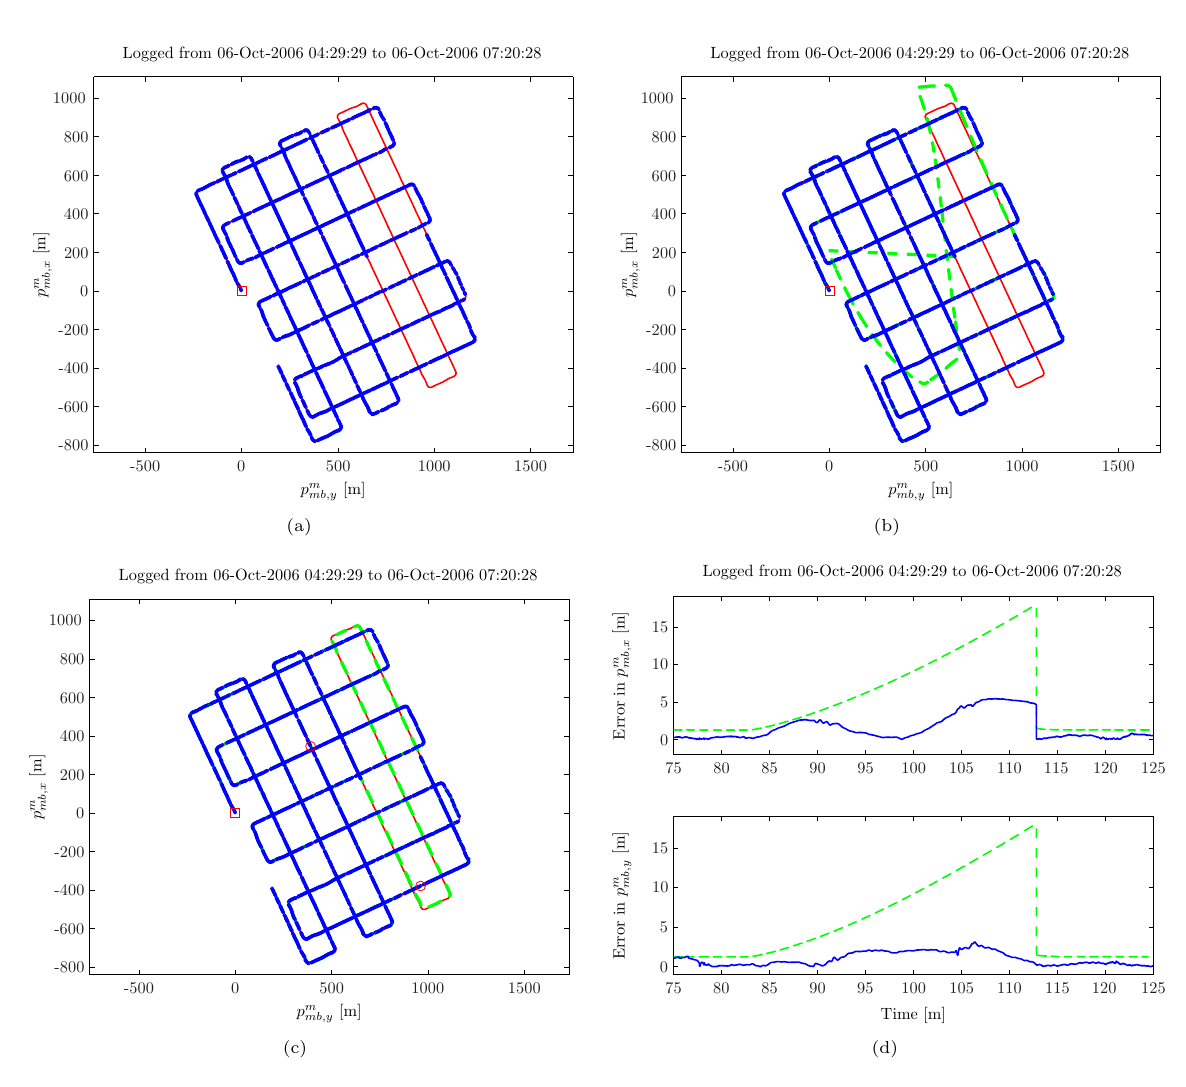
Figure 6: Traditional and model-aided INS evaluated according to case 1: (a) The red (solid) trajectory serves as basis for evaluating the navigation systems. The red square shows the initial position used in the KF. The blue (o) data show wild-point filtered position measurements logged topside. The segment without position measurements corresponds to 30 minutes. (b) Real-time navigation solution obtained with traditional INS shown in green (dashed). Other data as before. The system shows poor performance without position measurements. (c) Real-time navigation solution obtained with model-aided INS shown in green (dashed). Other data as before. The system shows excellent performance, also without position measurements. The circles (red) indicate 75 and 125 minutes into the run. (d) The true position errors (assuming basis is correct) for the model-aided INS in north and east are shown in blue (solid). The corresponding estimated real-time KF position uncertainties (1 σ ) are shown in green